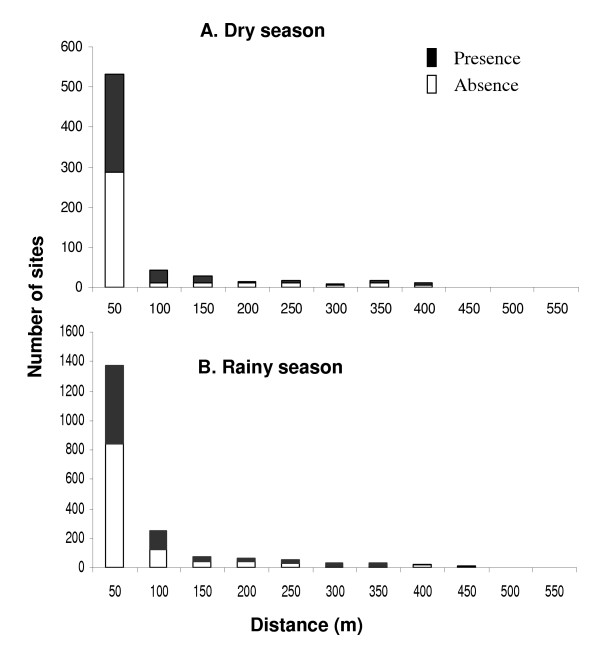
Distribution of anopheline larval habitats with respect to the distance to the nearest stream in the dry season (A) and rainy season (B).